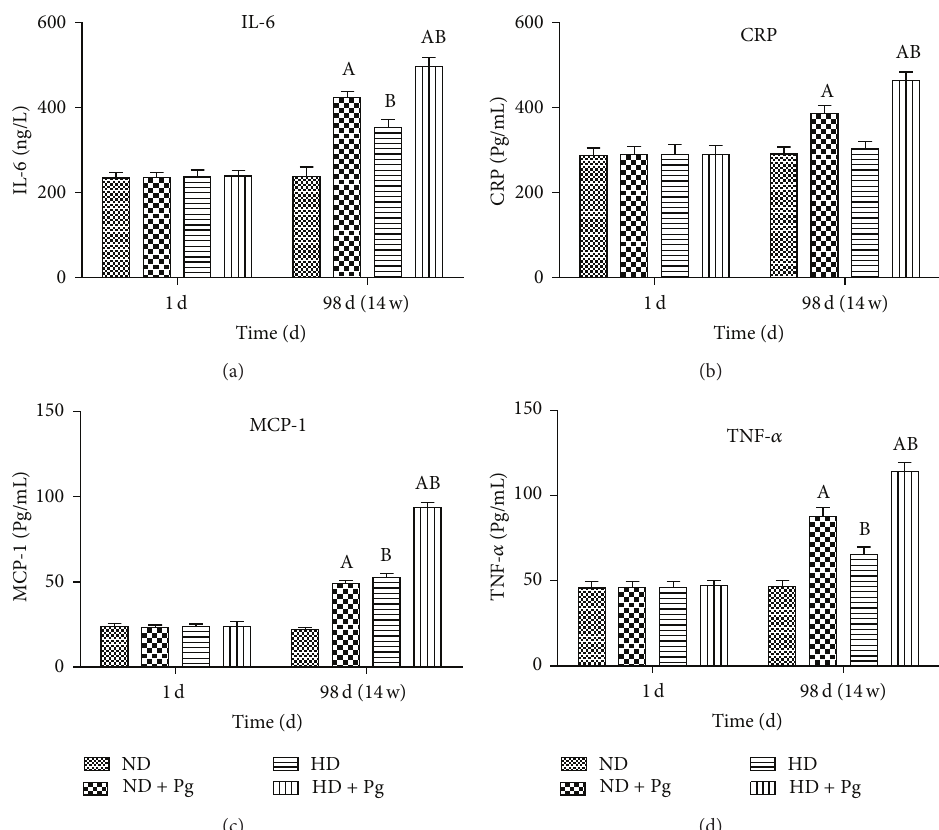
Figure 3: Expressions of inflammatory factors in peripheral blood. A: difference before and after Pg stimulation, 𝑃 < 0.05 ; B: difference before and after high-fat diet, 𝑃 < 0.05 . ND: normal diet; HD: high-fat diet.